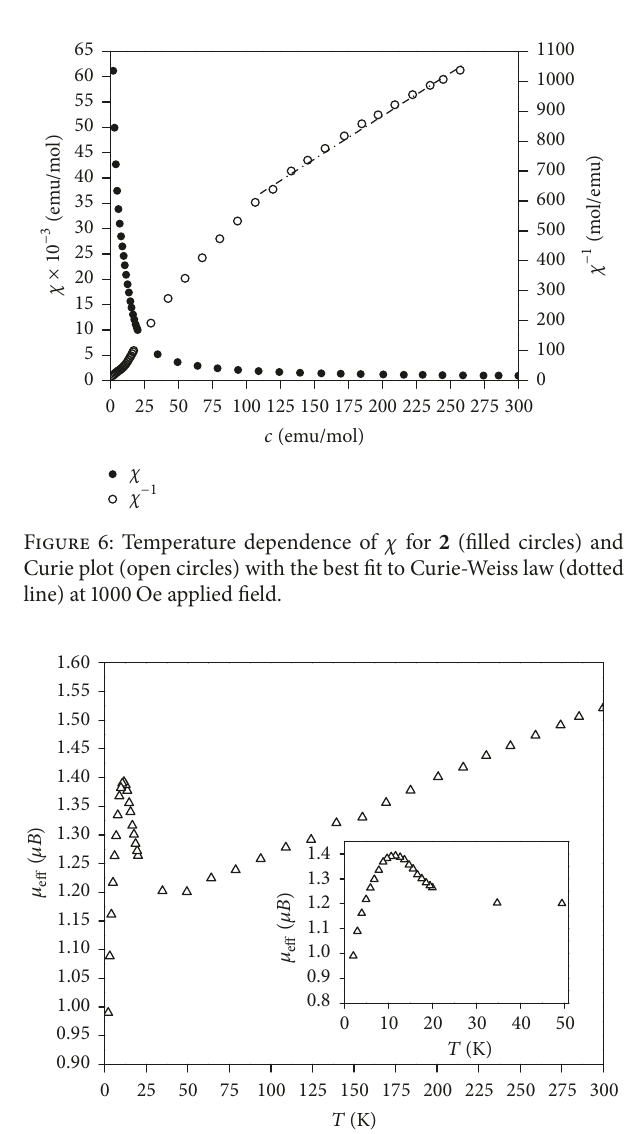
) versus T for 2 at a eff